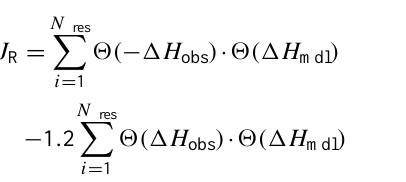
Figure 5. Comparison of difference between the H abl and the predicted (eqs ( 10 ), ( 13 )) and observed fire plume heights.